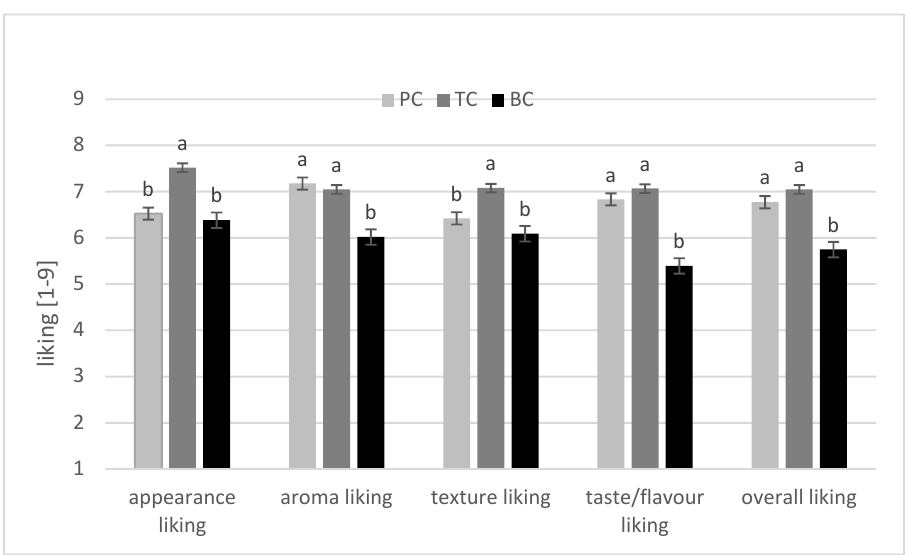
Figure 1. Consumers’ evaluation ( n = 50) of tested attributes and overall liking of gingerbread samples; TC—dough with the tomato addition, PC—pumpkin addition and BC—beetroot addition a, b—means marked with various letters differed significantly at p < 0.05.